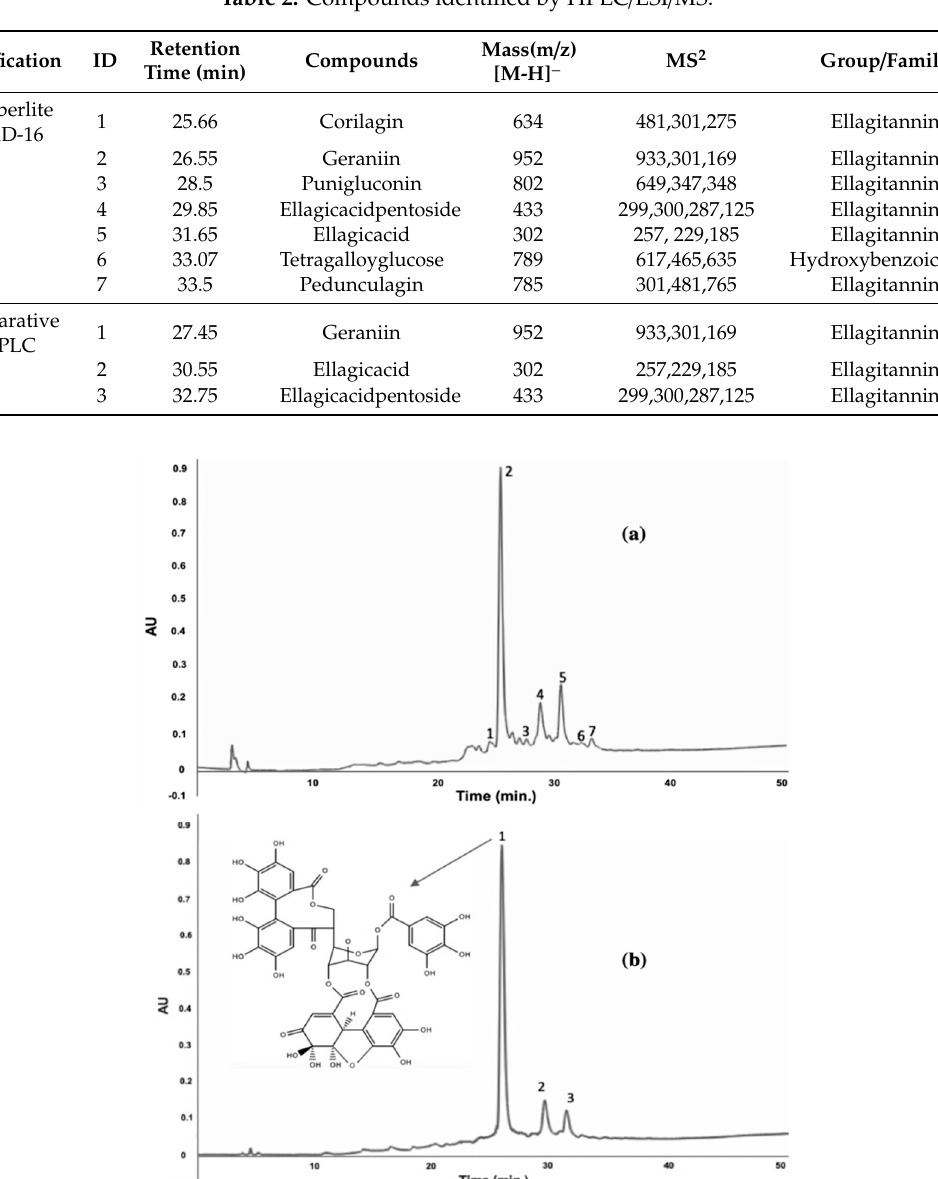
Sinlgeton, V.; Rossi, J. Colorimetry of total phenolics with phosphomolybdic-phosphotungstic acid reagents. Am. J. Enol. Vitic. 1965 , 16 , 144–158.